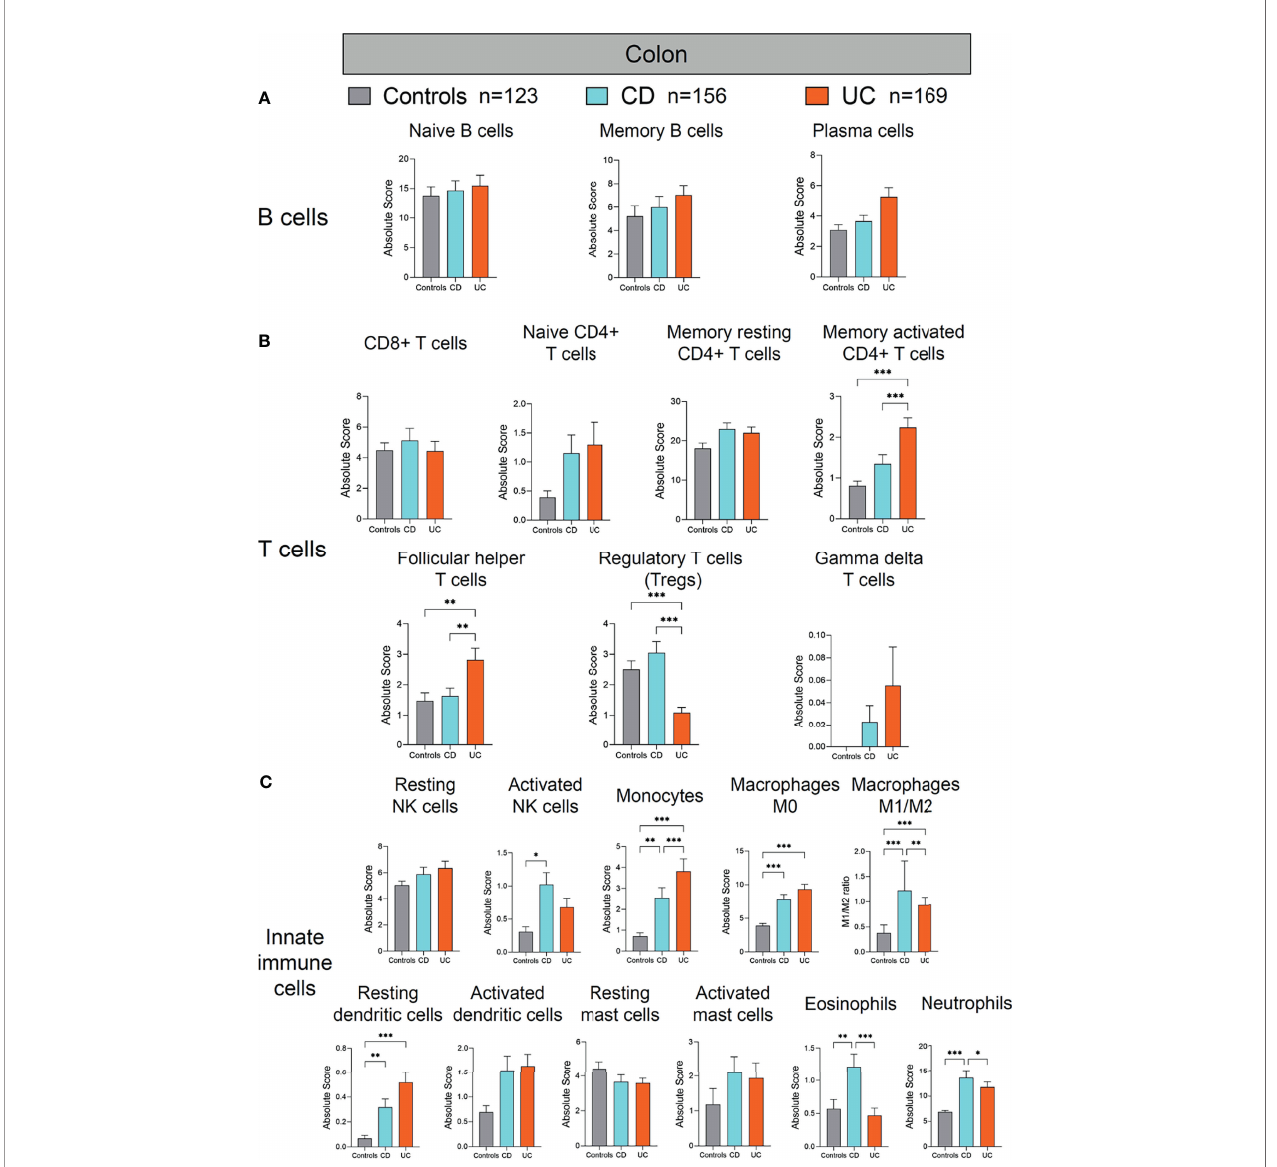
FIGURE 5 | Absolute quantity of immune cells pro fi ling in the colon of patients with IBD and healthy individuals. (A) Comparisons of the B-cell subpopulations among three disease subtypes in the colon. (B) Comparisons of the T-cell subpopulations among three disease subtypes in the colon. (C) Comparisons of the innate immune cell subpopulations among three disease subtypes in the colon. Statistical signi fi cance was determined by Kruskal – Wallis non-parametric test and Dunn ’ s multiple comparisons test. * p < 0.05; ** p < 0.01, *** p <